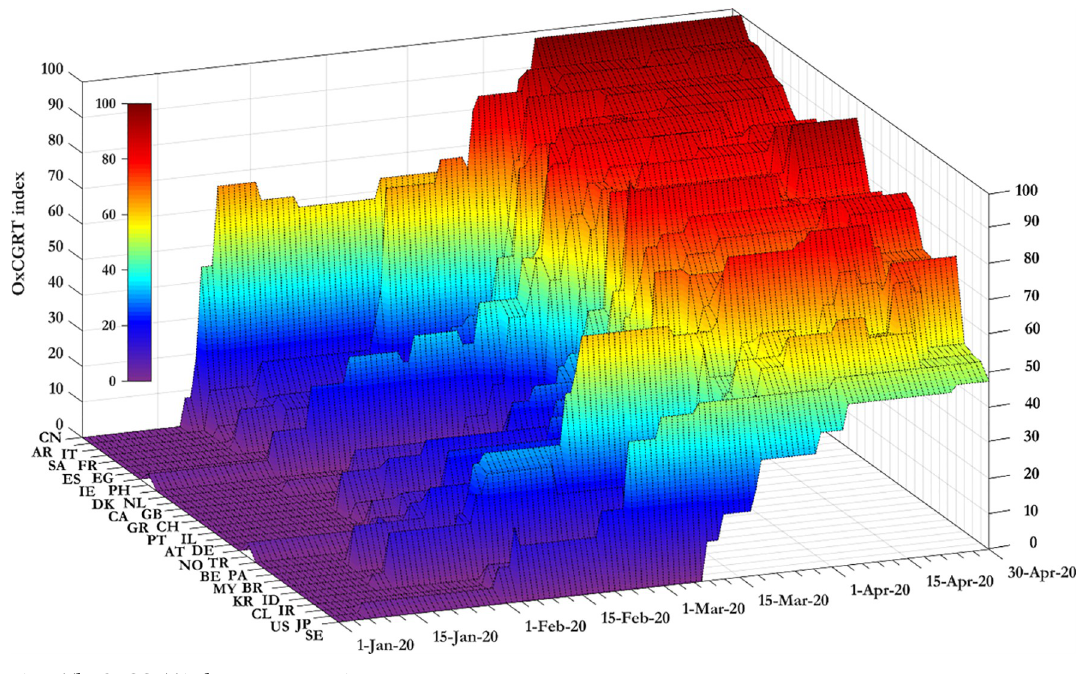
Fig 2. The OxCGRT index across